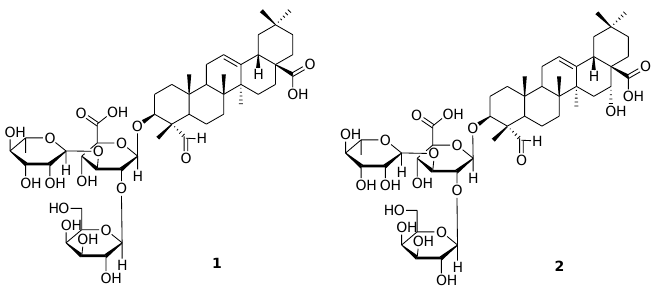
Figure 1. Chemical structures of the triterpenoid saponins ( 1 and 2 ).